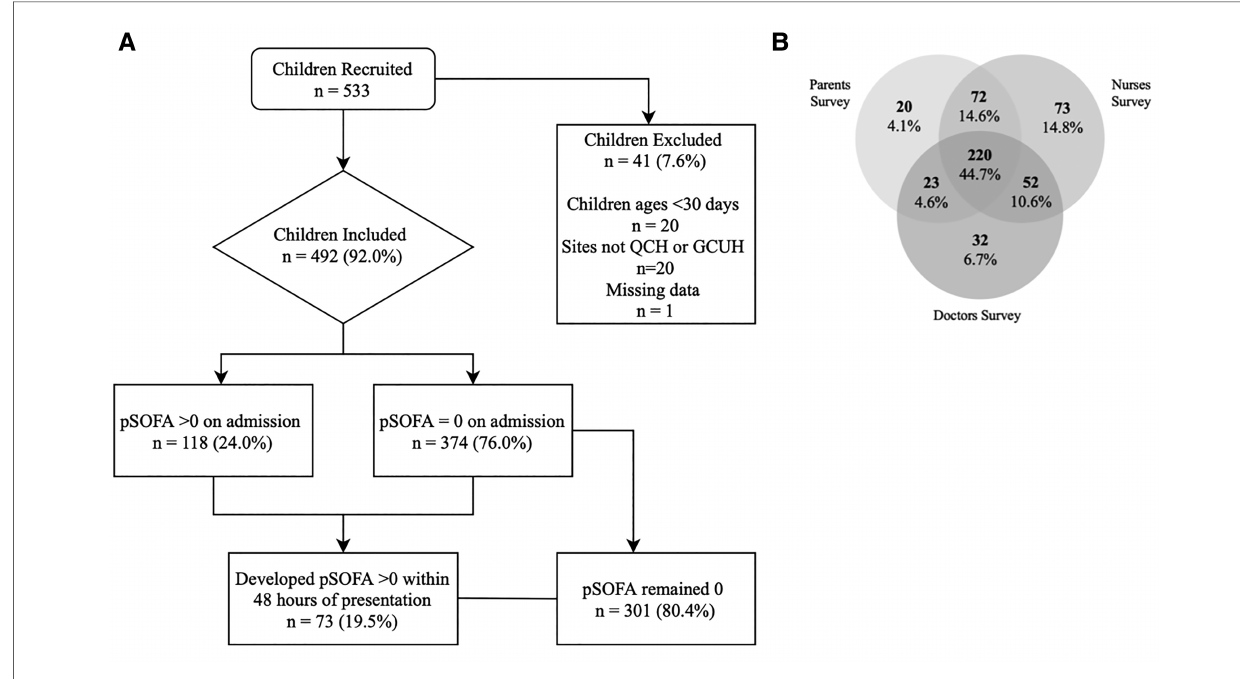
FIGURE 1 Participant fl ow diagram ( A ) and venn diagram ( B ) representing the inclusion of patients in relation to sepsis, and the number of surveys completed for parents, nurses and doctors,